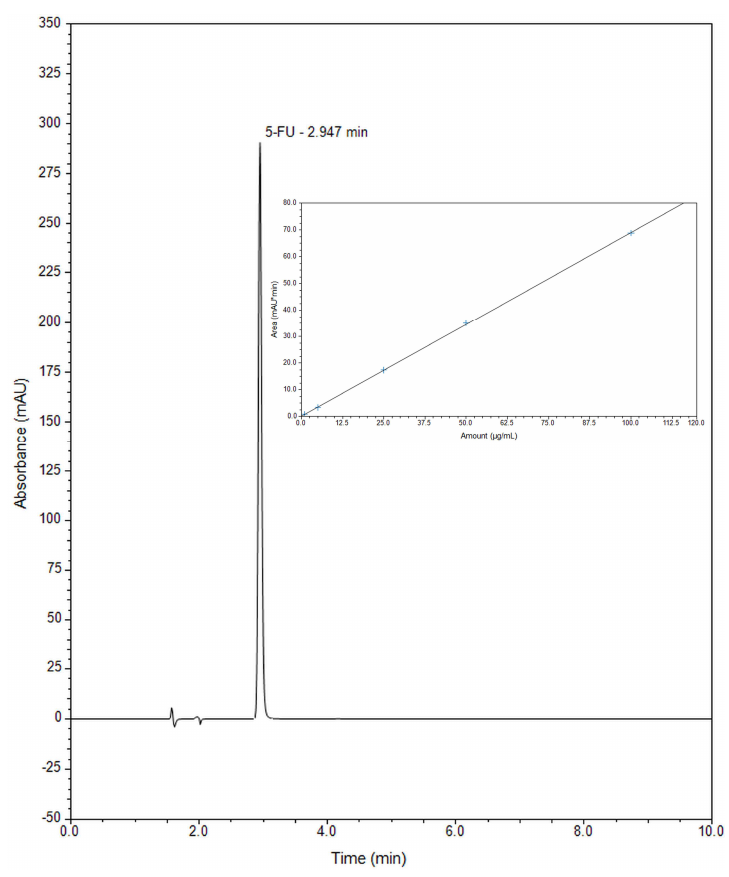
Figure 9. Chromatogram of 5-FU standard solution (25 µ g/mL) and calibration curve for 5-FU.